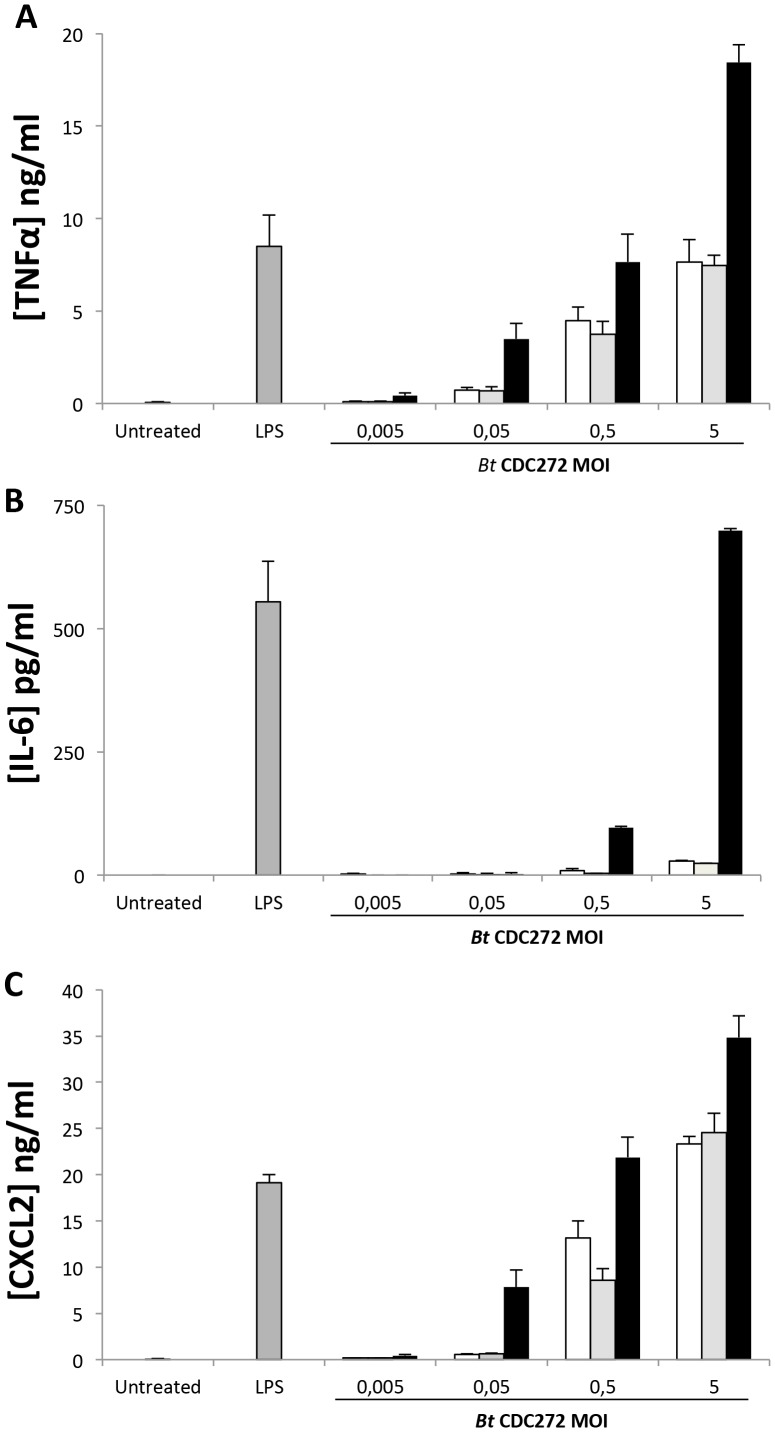
Cytokine production by mouse macrophage cell line RAW264.7 exposed to BtCDC272 grown in different conditions and at different M.O.I.Confluent monolayers of cells were incubated with bacteria cultured at the indicated conditions. Bacteria were added at MOI of 0.005, 0.05, 0.5 or 5 for 4 hours to confluent monolayers of RAW264.7 cells. LPS (100 ng/ml from E. coli Serotype 055:B5; Sigma-Aldrich) was used as positive control of macrophage activation. Murine CXCL2, TNF-α and IL-6 levels were measured in cell supernatants by ELISA Results are mean± SEM of two independent experiments.